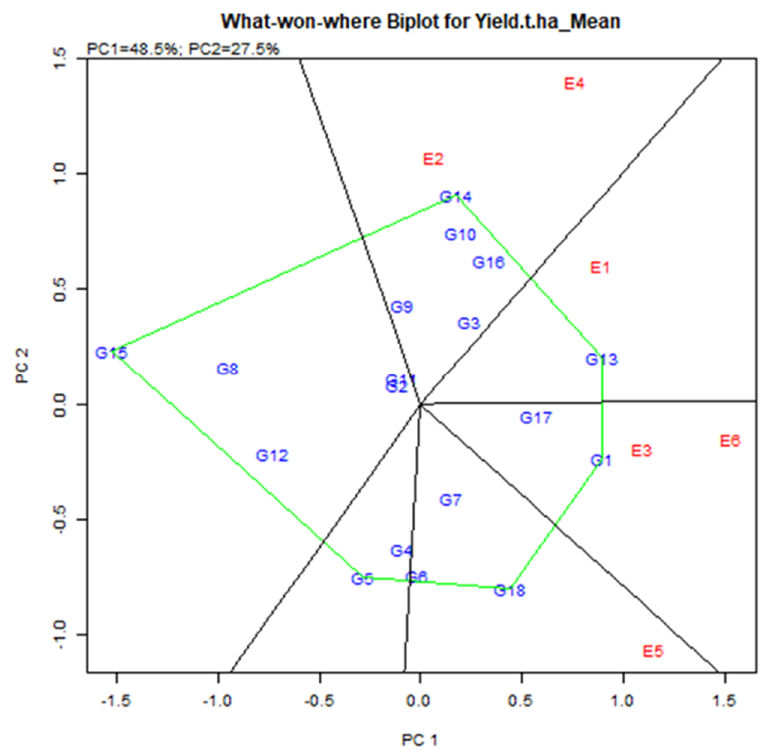
Figure 7. Mega-environments with winning genotypes during two consecutive seasons.